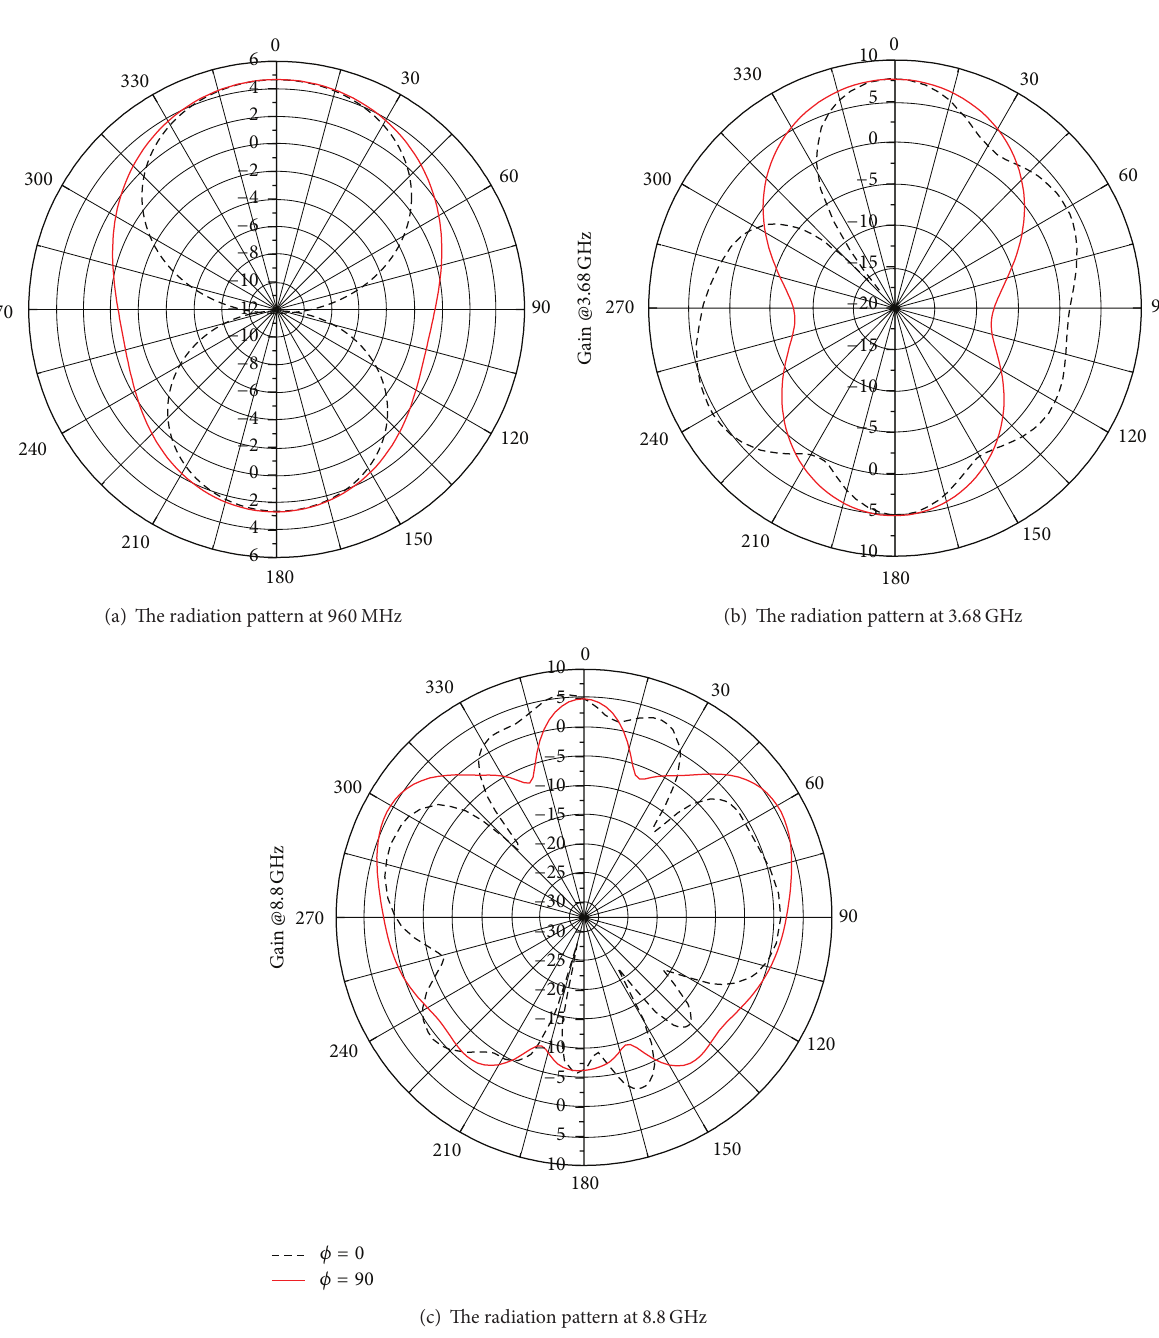
Figure 4: The radiation patterns of the proposed antenna. (a) The radiation pattern at 960 MHz. (b) The radiation pattern at 3.68 GHz. (c) The radiation pattern at 8.8